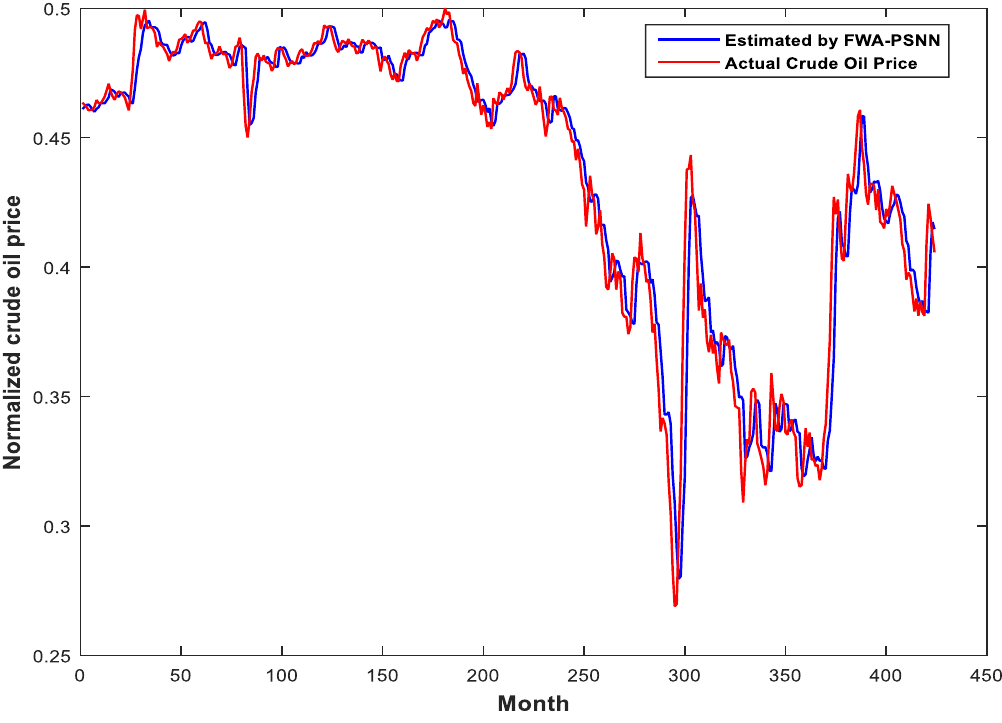
Figure 8. Actual crude oil prices v/s estimated by FWA-PSNN from monthly crude oil price time